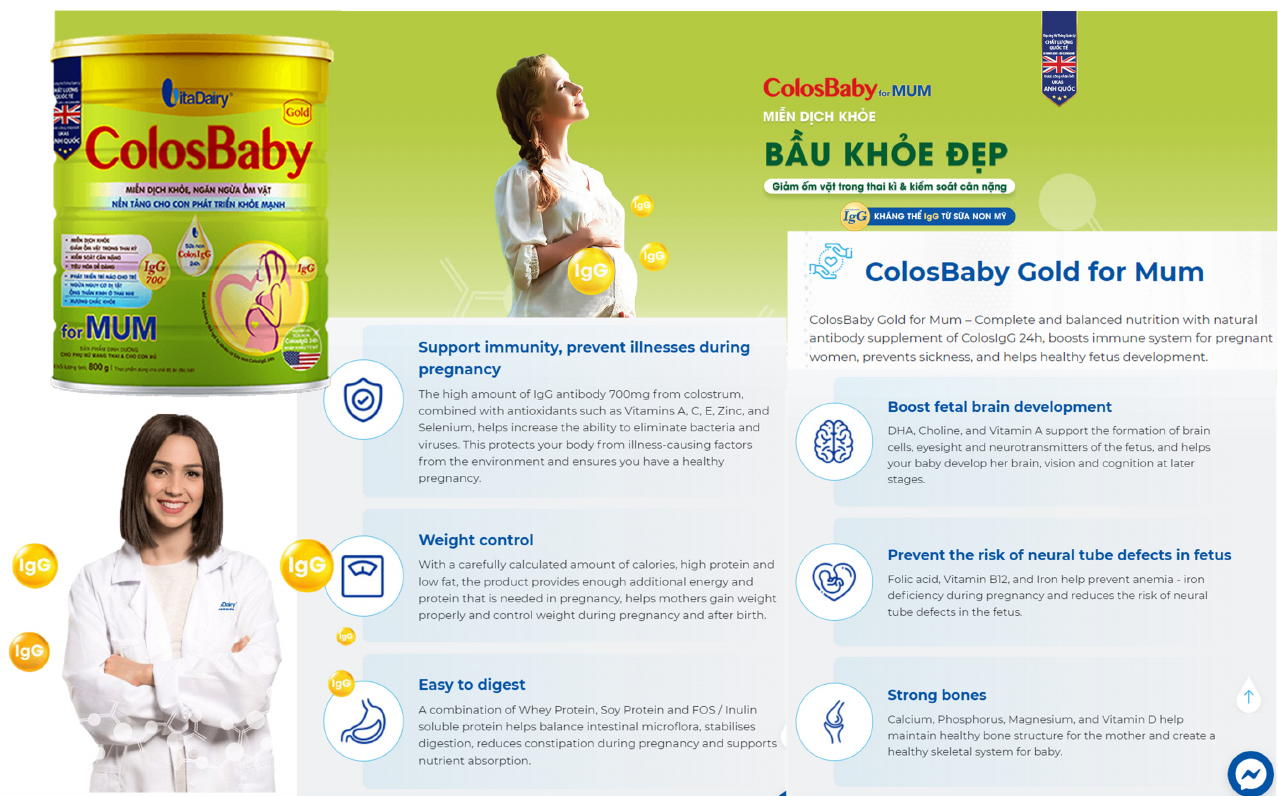
Figure 5. ColosBaby for Mum claims product benefits health of mother, fetus, and newborn